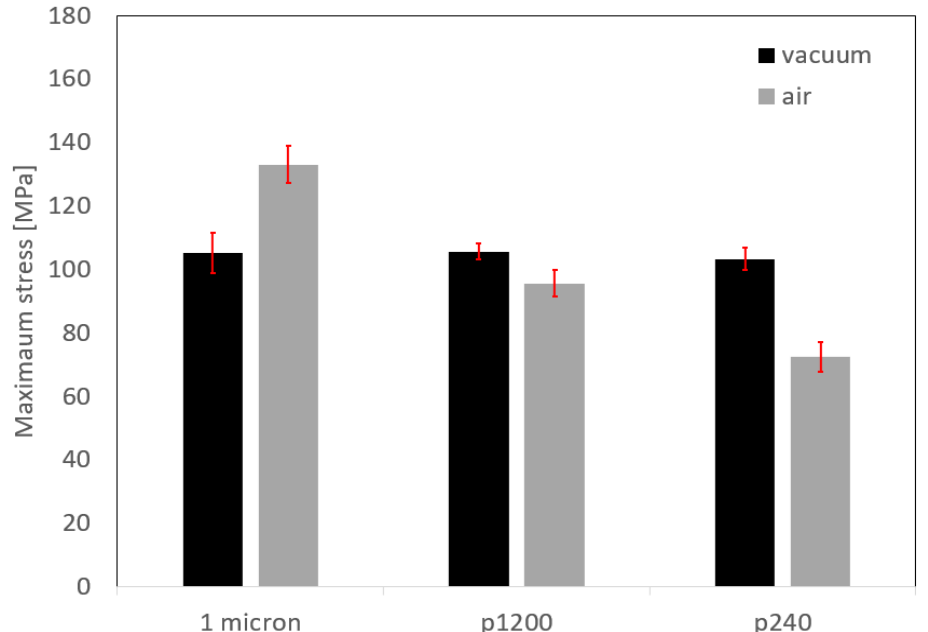
Figure 17. Tensile strength of AA6061 – AA1050 pairs with different initial surface roughness after diffusion bonding experiments for 24 h in a vacuum and in air.